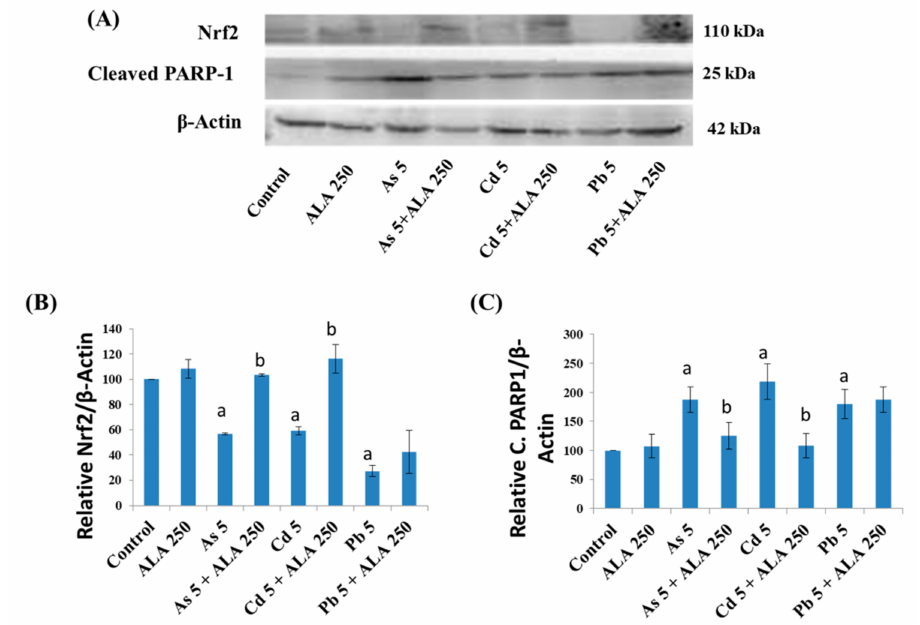
Figure 10. ( A ) Western blot analysis of protein expressions, and quantification of ( B ) Nrf2 and ( C ) cleaved PARP1 in the Caco-2 cells after treatment with metals with ALA for 48 h. The values of the bars indicate the mean ± SEM ( n = 3). Here, “a” denotes a significant difference compared to the control group ( p < 0.05), and “b” denotes a significant difference compared to the associated metal group ( p <